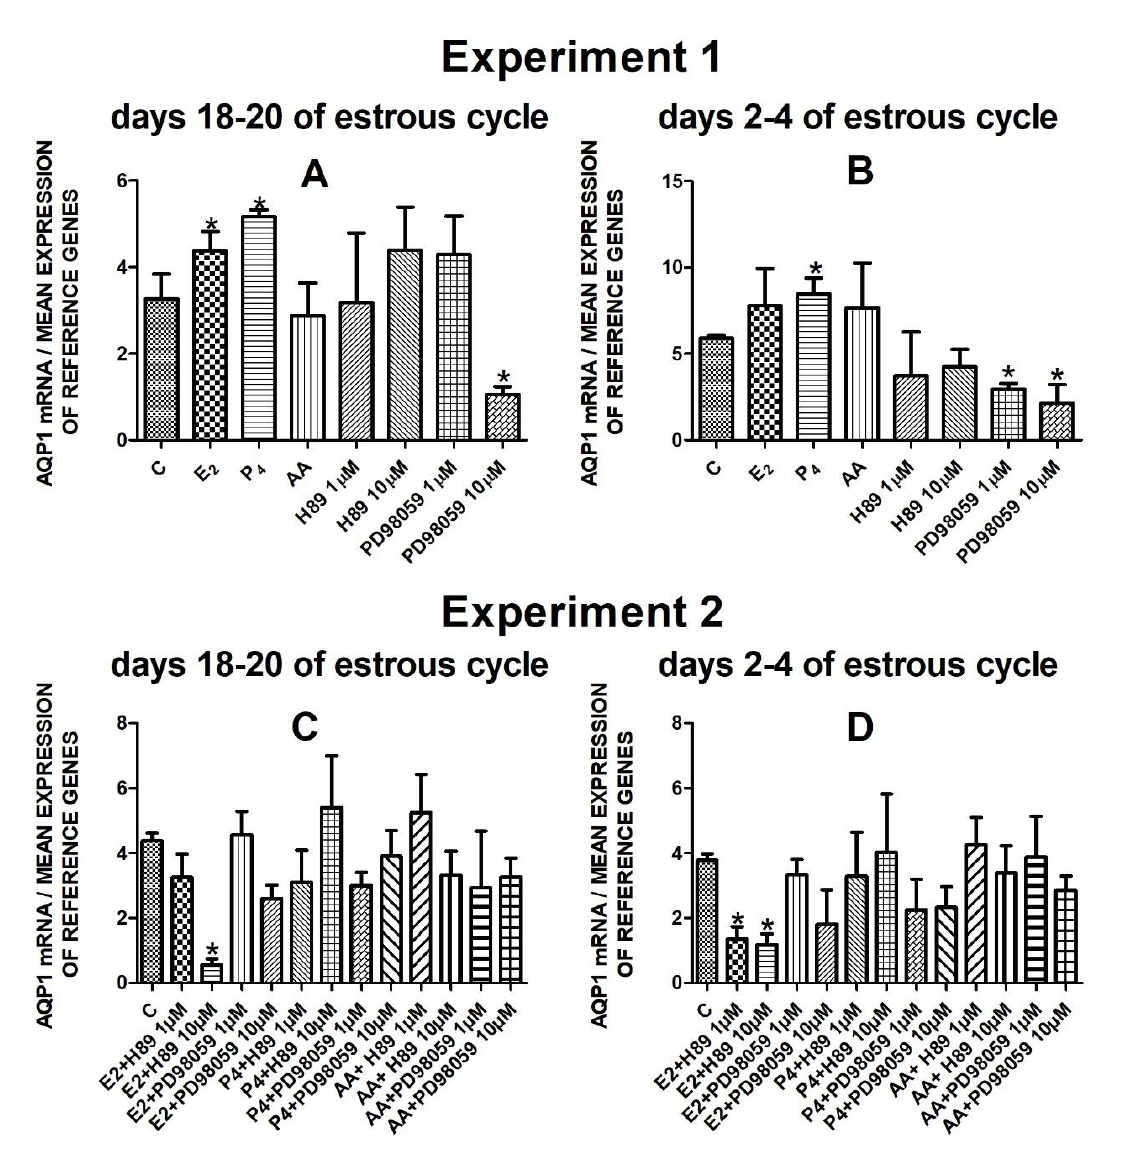
Figure 1. The influence of estradiol (10 nM), progesterone (10 − 6 M), arachidonic acid (10 − 5 M), and kinase inhibitors H89 (1 µ M, 10 µ M) and PD98059 (1 µ M, 10 µ M) and mix of these factors on Aquaporin 1 mRNA expression (Experiment 1: ( A , B ), Experiment 2: ( C , D )) in the porcine luminal epithelial cells from days 18–20 and 2–4 of the estrous cycle. The gene expression was determined by quantitative real-time PCR. Results are reported as the means ± S.E.M. ( n = 5). Bars with different superscripts differ ( p < 0.05) and are marked by (*).